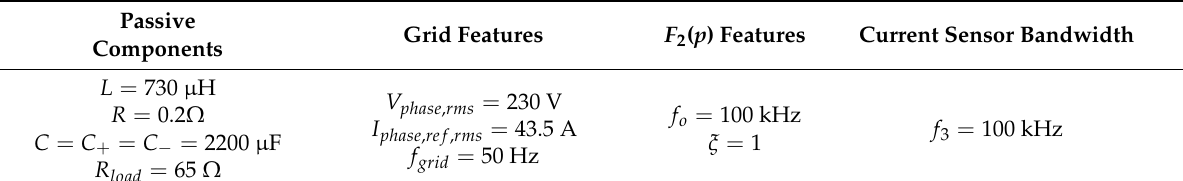
Table 1. Simulations parameters.